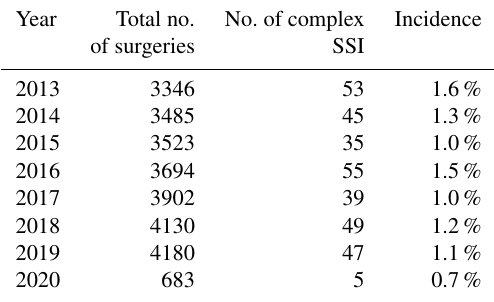
Table 2. Annual number of confirmed complex surgical site infec- tion cases within 90d of surgery between January 2013 and